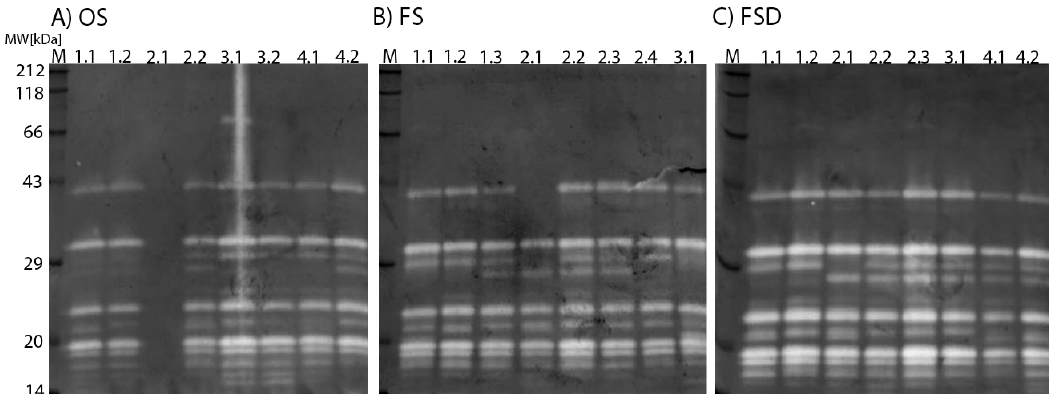
Fig. 5. Protease activity in whiteleg shrimp Litopenaeus vannamei in all treatments: (A) OS, (B) FS and (C) FSD (see Table 1 for treatment details). MW is the marker showing the molecular weight in kDa. Bands indicate the protease activity by hydrolyzed casein, where lighter bands indicate higher activity. The numbering of lanes identifies individual shrimp from each treatment. Note that sample 2.1 in all treatments indicates possible sample degradation or other loss